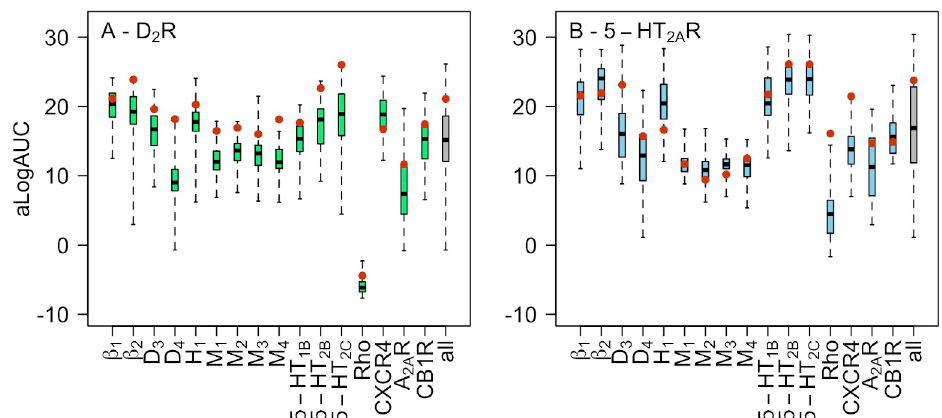
Fig 3. Ligand enrichment by homology models. Distribution of aLogAUC values for (A) D 2 R and (B) 5-HT 2A R models based on 16 different templates. Distributions are shown using a boxplot representation. Each boxplot describes the results for 50 models obtained based on one template. The box represents the 50th percentile of the data and the black band shows the median value. The lowest and highest aLogAUC values are represented by the whiskers. The gray boxplot corresponds the results of all 600 models based on aminergic receptor templates. Ensemble enrichments are represented by red filled